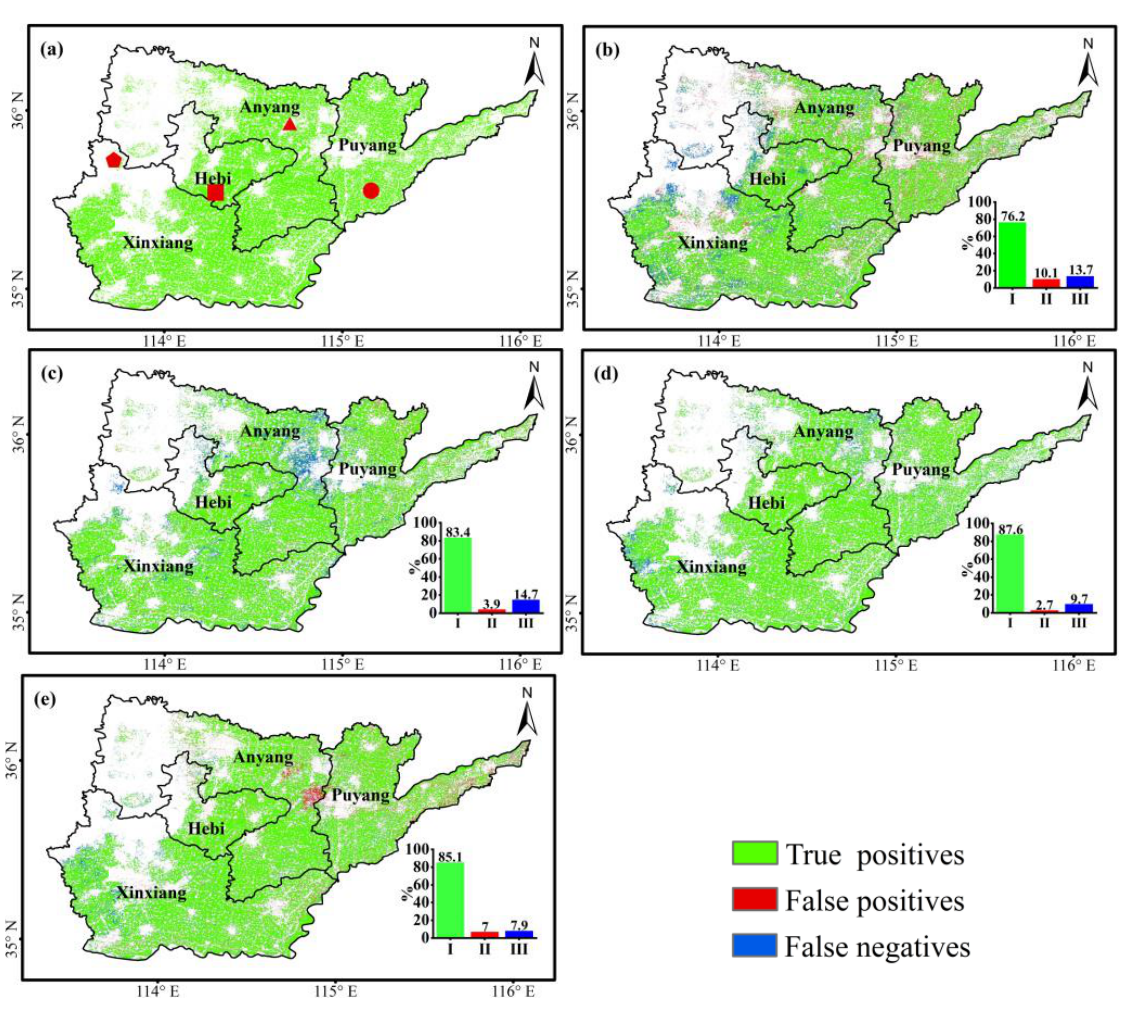
Figure 3. Winter wheat spatial distribution from five growth periods and their difference produced by the random forest classification. ( a ) The spatial distribution of winter wheat at the jointing-heading stage (reference image), it was subtracted from the winter wheat classification corresponding to other periods to generate the difference maps ( b – e ). In the bar charts, I, II and III represent the ratio of the number of correctly predicted, wrongly predicted and ‘missing’ winter wheat pixels to the union of the number of predicted winter wheat pixels and the true number, respectively. The red square, circle, triangle and pentagon represent the locations of the subsets shown in Figure